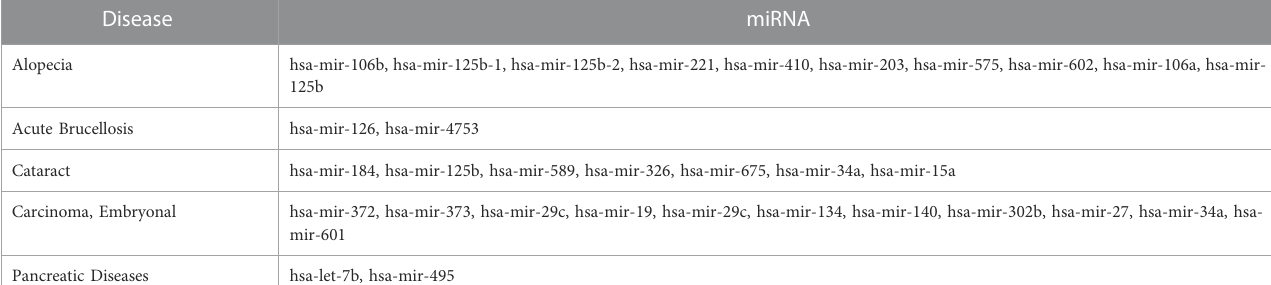
TABLE 1 An example grouping procedure based on disease and miRNA relationships using HMDD.